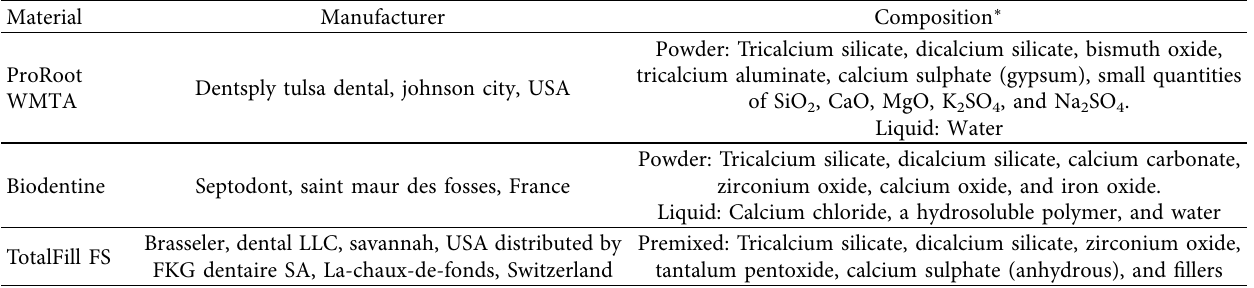
Table 1: The manufacturers and compositions of the tested